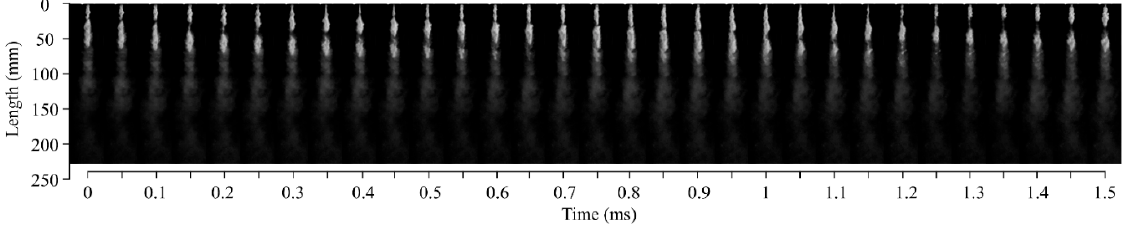
Figure 6. Variation of cavitation cloud with time at a working pressure of 10 MPa.